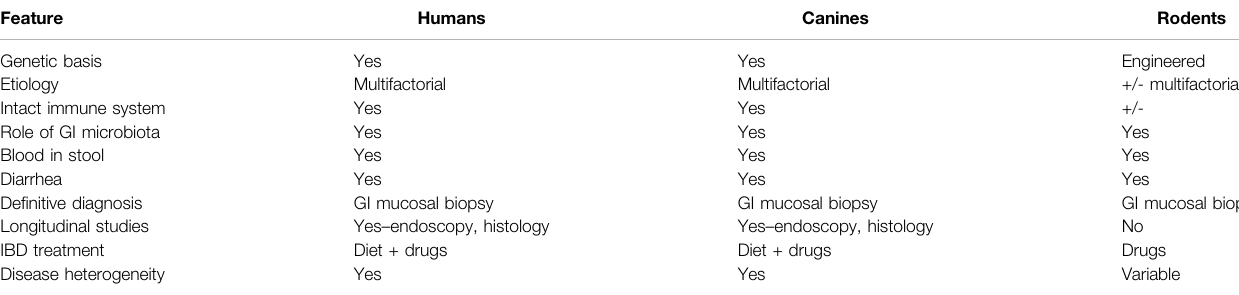
TABLE 1 | Comparison of human IBD with cIBD in dogs and traditional rodent models of IBD.